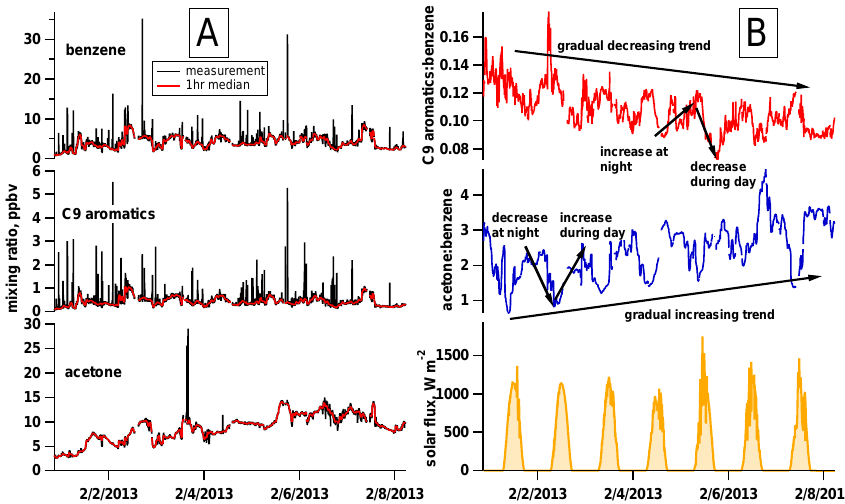
Figure 2. Description of trends in VOC concentrations and ratios. (a) Mixing ratios of benzene, C9 aromatics, and acetone (black), and a 1h running median to isolate spikes (red). (b) Ratios of C9 aromatics (top) and acetone (center) to benzene. Sunlight intensity is shown beneath. The spikes visible in (a) have been removed to isolate longer-term trends in VOC behavior (discussed in text).